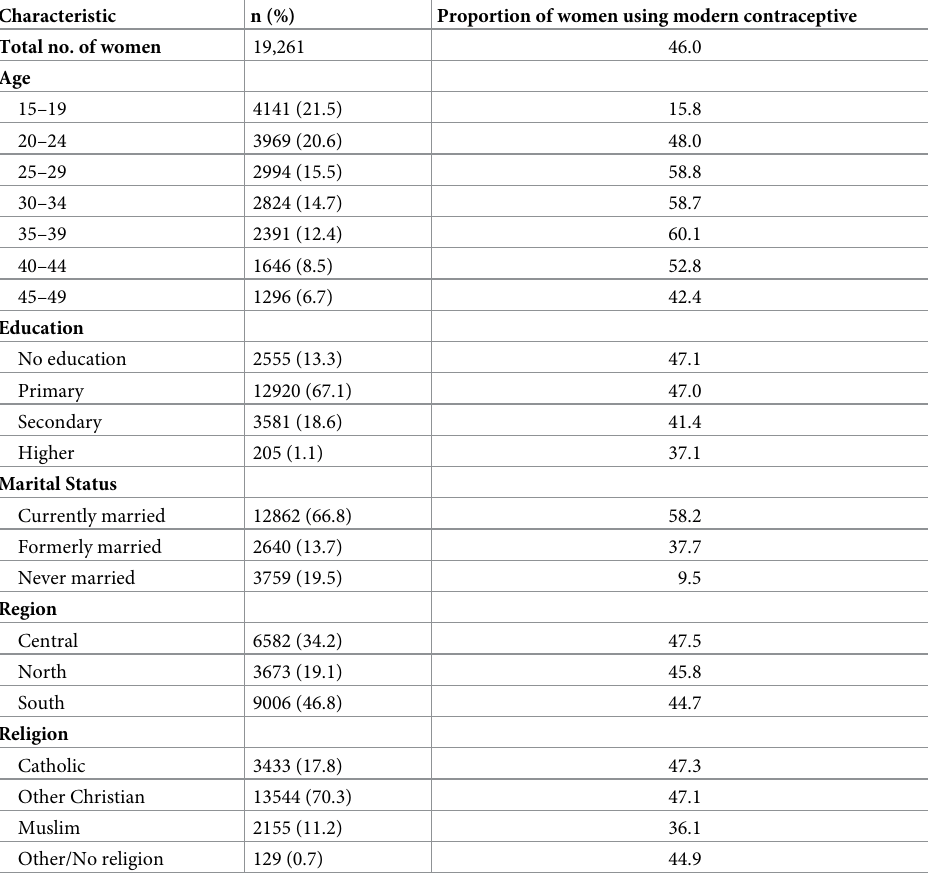
Table 3. Background trait of women in rural DHS clusters and associated modern contraceptive use for each trait.